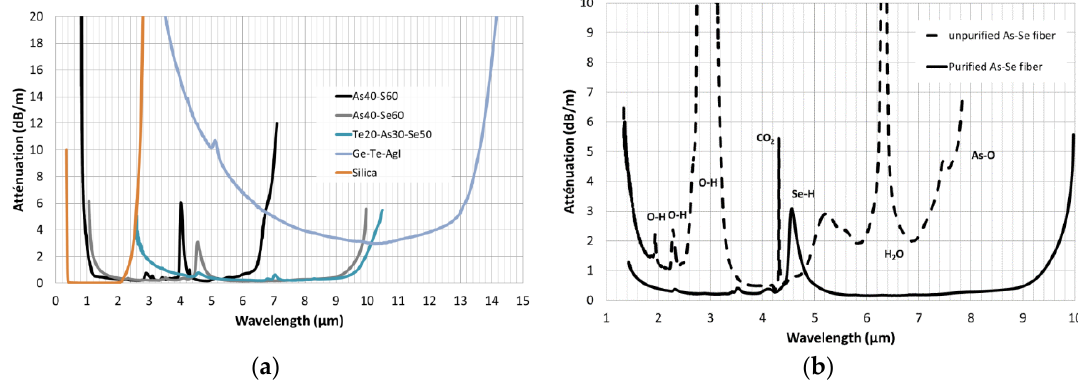
Figure 6. Mid-infrared transmission of chalcogenide optical fiber: ( a ) Depending on the chemical composition and ( b ) Role of the purification processes.